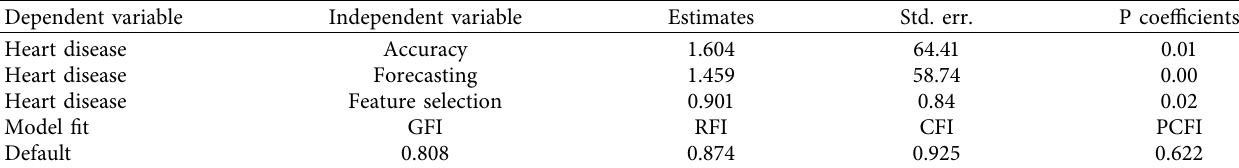
Figure 4: path Table 5: p coefficients of all variables.